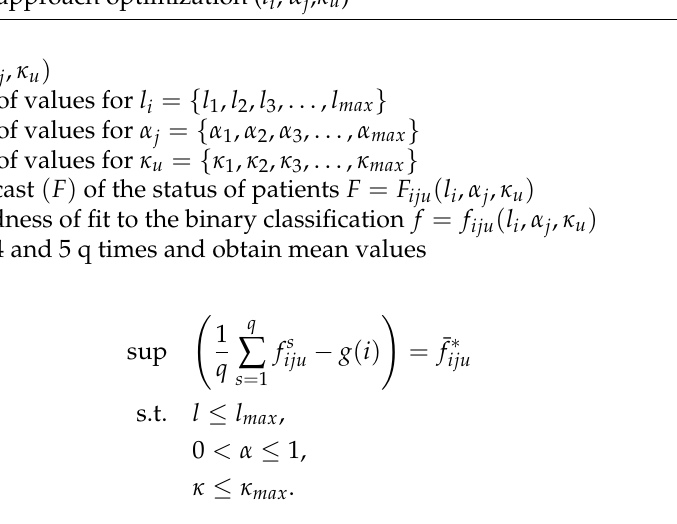
Algorithm 2 Grid approach optimization ( l i , α j , κ u